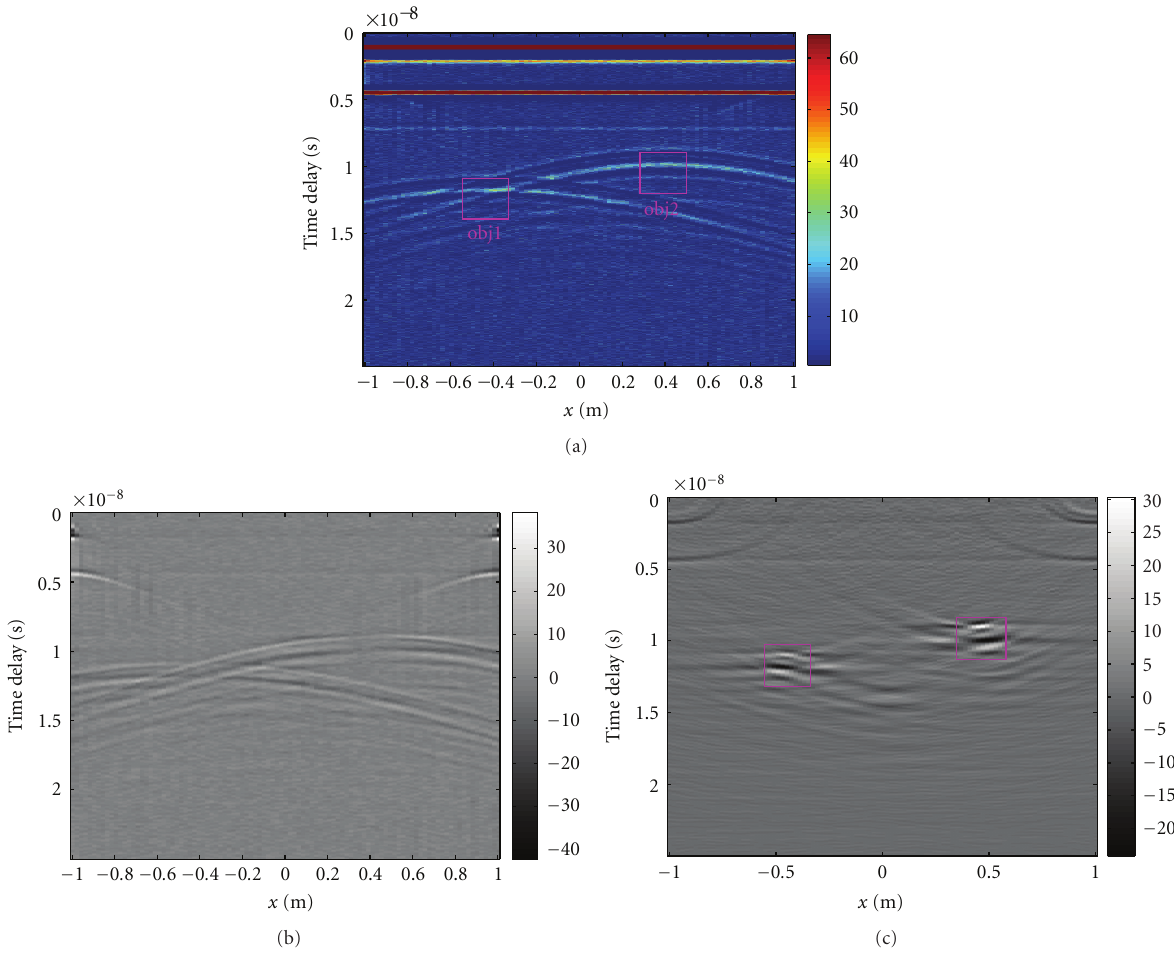
Figure 3: Preprocessing results of TWI. (a) Forward profile. (b) FK filtered result. (c) FK migration result.